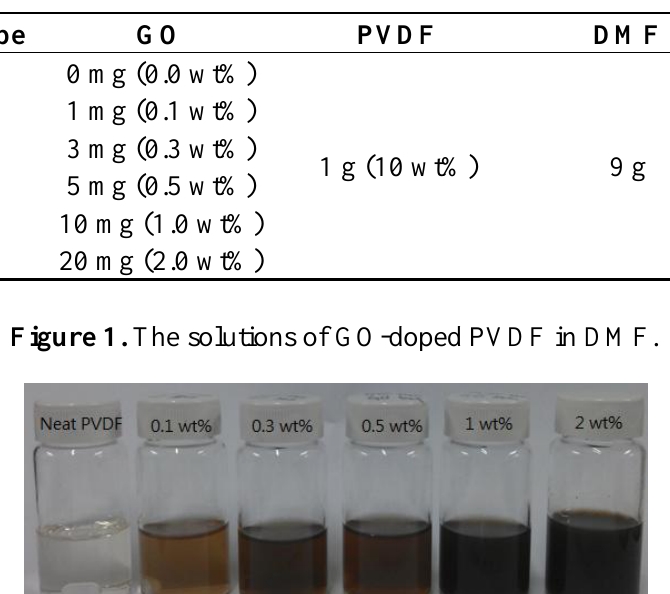
Table 2. The PVDF GO-doping recipes.